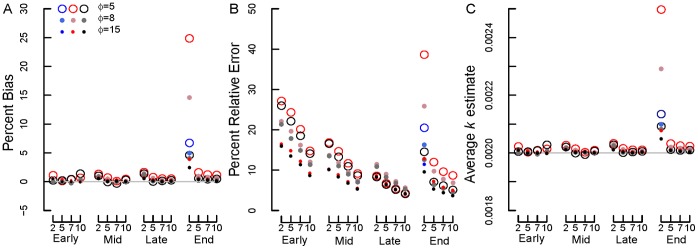
Simulation results for beta-distributed errors (option 2), k = 0.002.(A) Percent bias, (B) percent relative error, and (C) average k estimate. Early, mid, late and end are early, mid, late and end stage decomposition simulations. The numbers 2, 5, 7 and 10 are the numbers of measurements used in each simulation. Blue circles = NLS, Red circles = Normal ML, gray/black circles = Beta ML. In most cases, nls = Normal ML so that the red circles cover the blue circles. In panel (A), the gray line shows 0% bias. In panel (C), the gray line shows the true k value, 0.002 d−1.